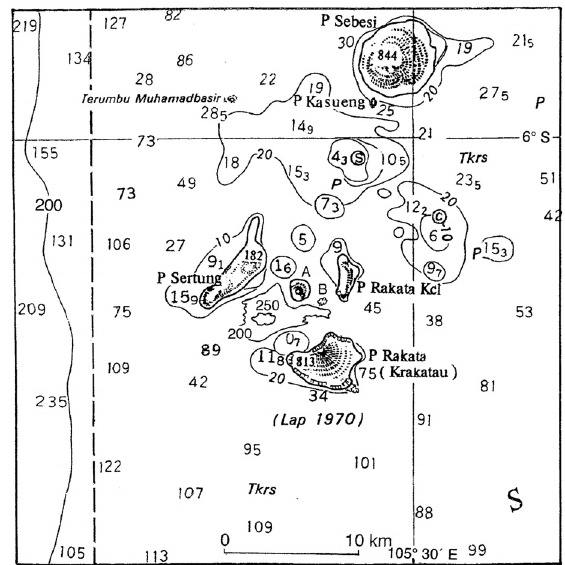
Figure 5. A part of Indonesian Chart around Krakatau Islands sur- veyed in 1970 by Kepala Dinas Hidro-Oseanografi. Spot depths are in meter. The isobaths of 200 and 250 m in the central part are drawn by the present author. Sertung and Rakata Kcl are another names of Verlaten and Lang, respectively. ⓢ and ⓒ near the cross- ing of the longitude and latitude lines denote Steers and Calmeyer reefs, respectively. A Anak Krakatau, B Bootsmans Rots.